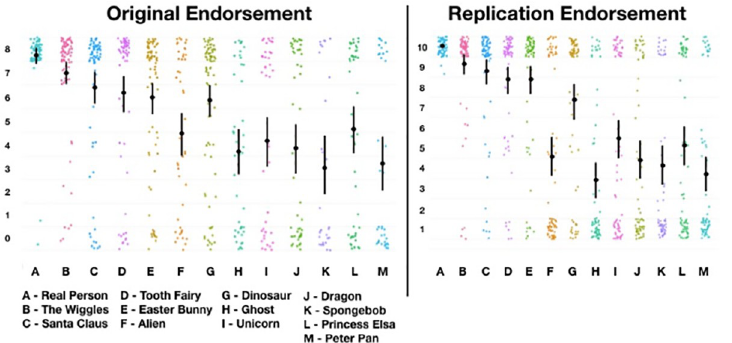
Fig 7. Plot of original vs replication endorsement values for